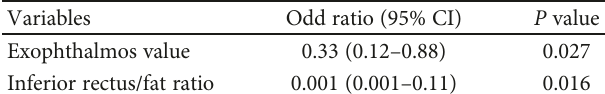
Table 3: Predictive factors for response to GC in GO